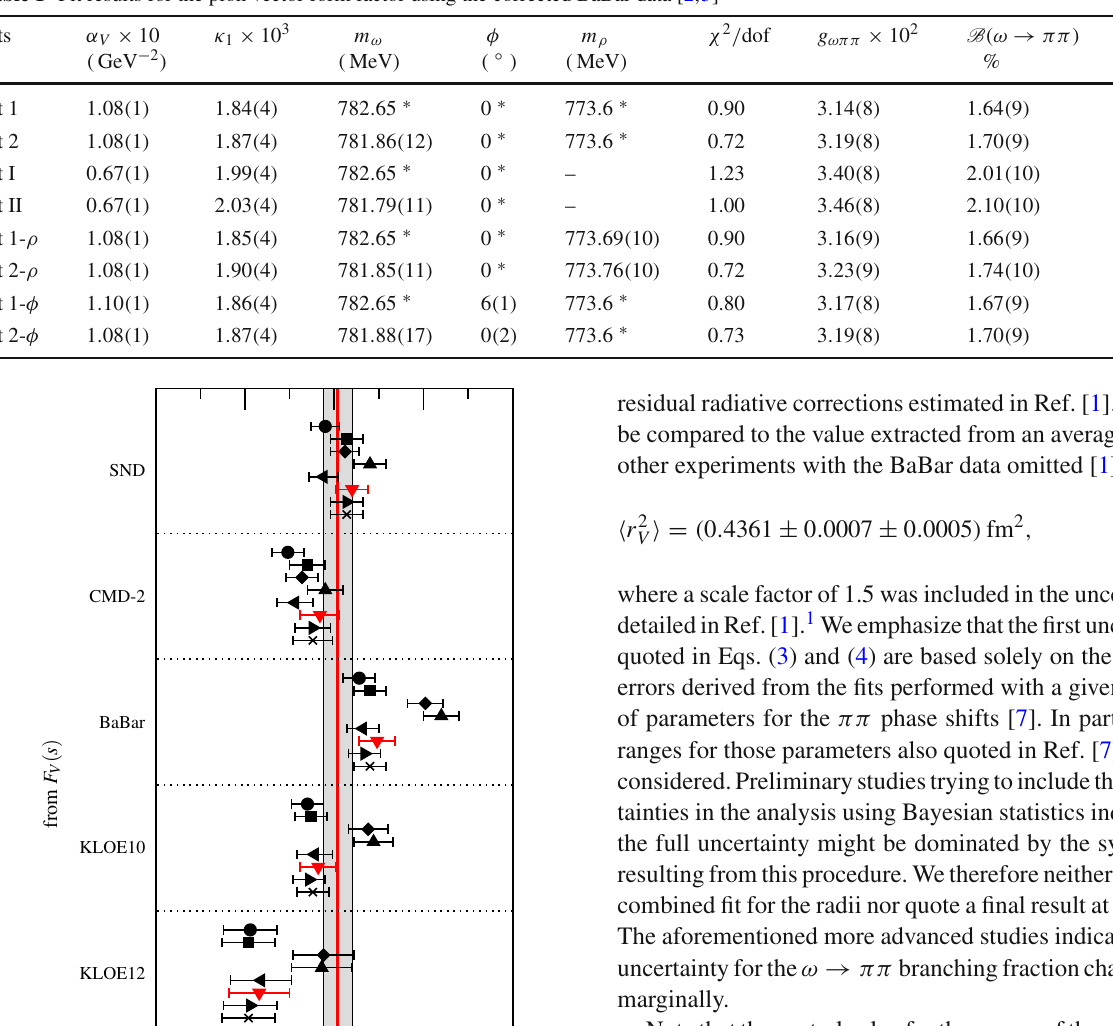
Table 1 Fit results for the pion vector form factor using the corrected BaBar data [2,5]